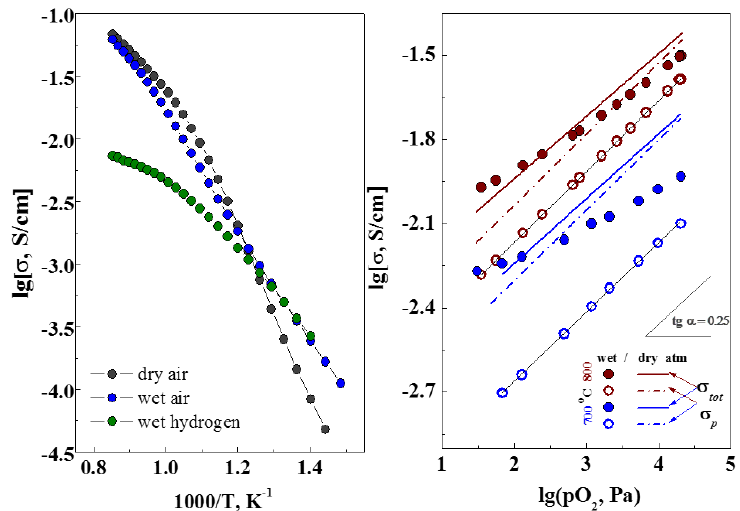
Figure 9. Conductivity dependences on the temperature ( a ) and on the oxygen partial pressure ( b ) for the LCS5 sample ceramics in dry ( p H 2 O < 0.1 kPa) and wet ( p H 2 O = 4.5 kPa) air, as well as in a wet ( p H 2 O = 4.5 kPa) reducing